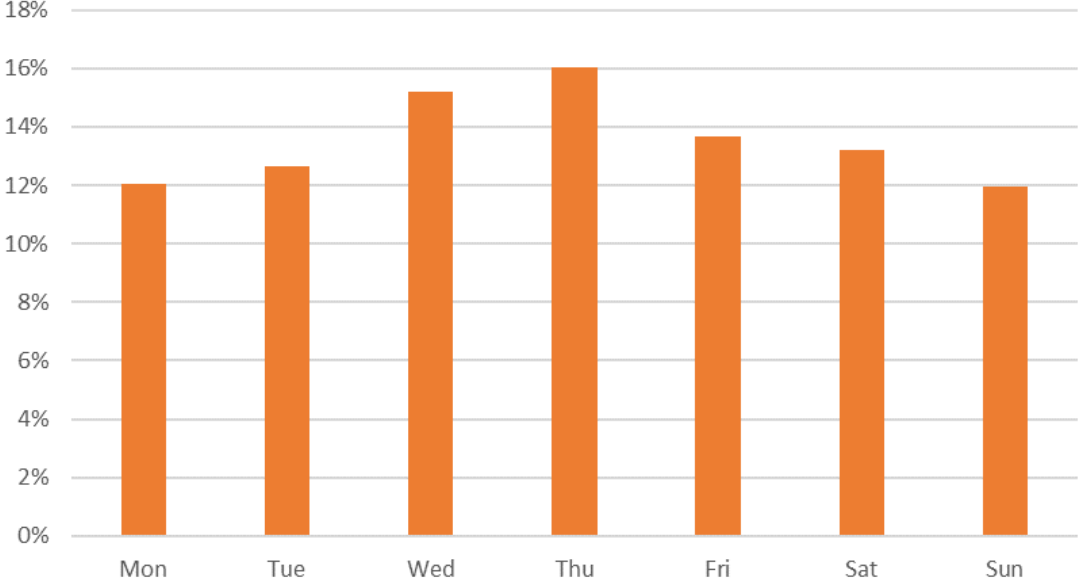
Figure 2. Percentages of daily cases out of total weekly cases on each day of the week. Nineteen week averages between 1 June and 11 October